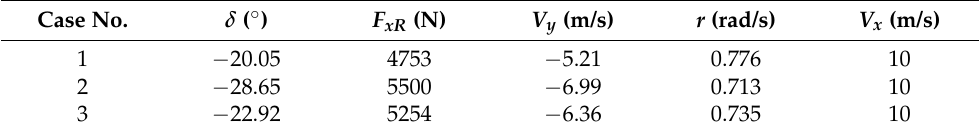
Table 1. Equilibrium points used in the controller evaluation simulations.